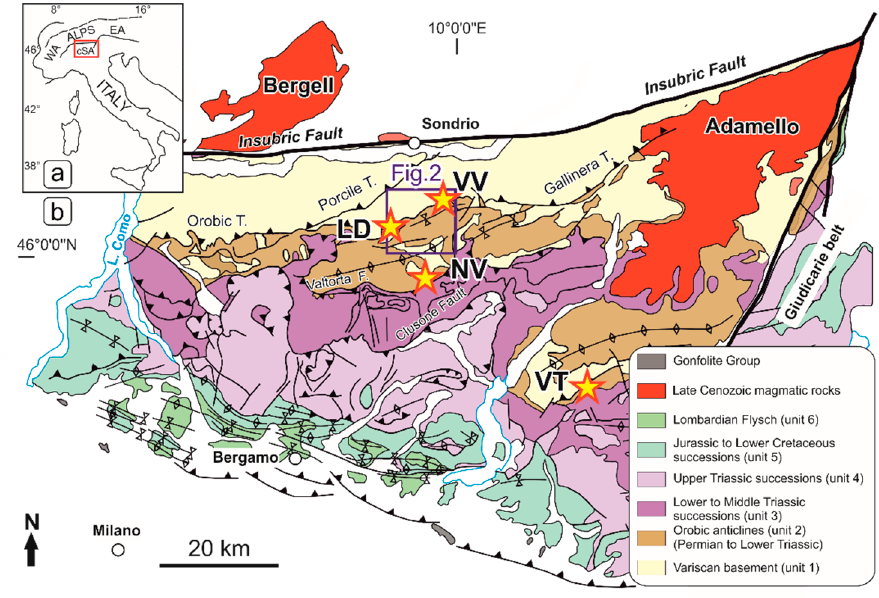
Figure 1. Tectonic scheme of the cSA, modified after [8]. The localities of tourmalinite occurrences are Figure 1. ( a ) Tectonic scheme of the cSA, modified after [8]. ( b ) The localities of tourmalinite highlighted with yellow stars. LD: Lago del Diavolo-Mt. Aga; NV: Novazza Uranium ore deposit; VT: occurrences are highlighted with yellow stars. LD: Lago del Diavolo-Mt. Aga; NV: Novazza Val Trompia tourmalinites; VV: Val Vedello Uranium ore deposit. The extent of Figure 2 is